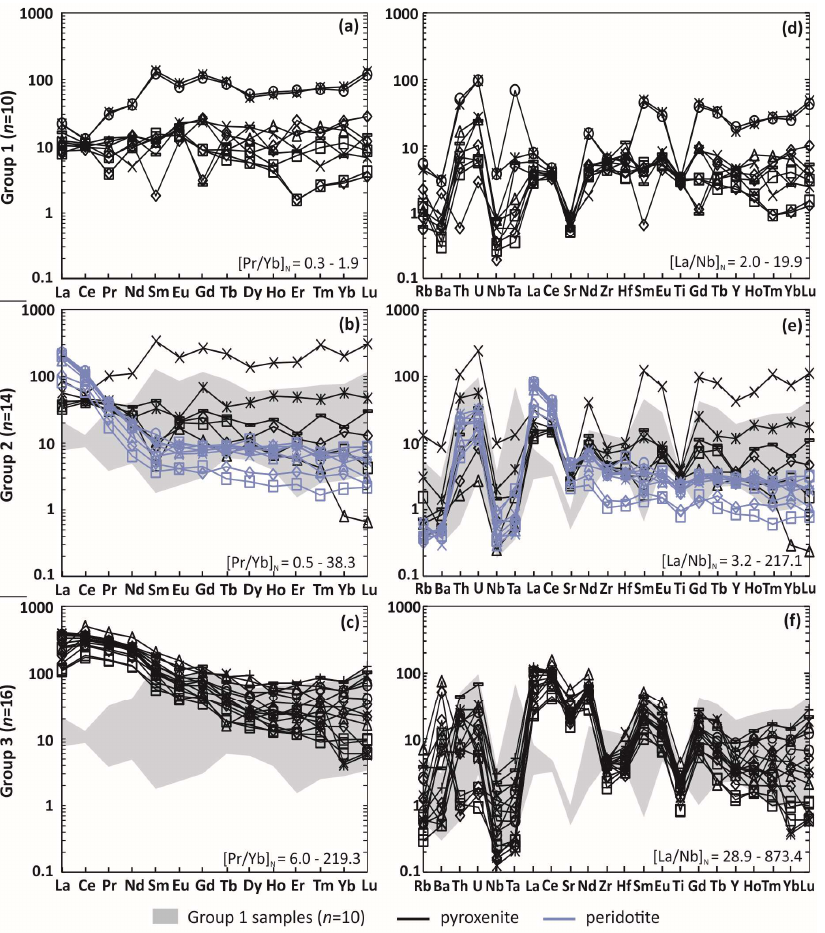
Figure 12. Chondrite-normalised REE ( a – c ) and primitive mantle-normalised [88] trace-element plots ( d – f ) for clinopyroxene